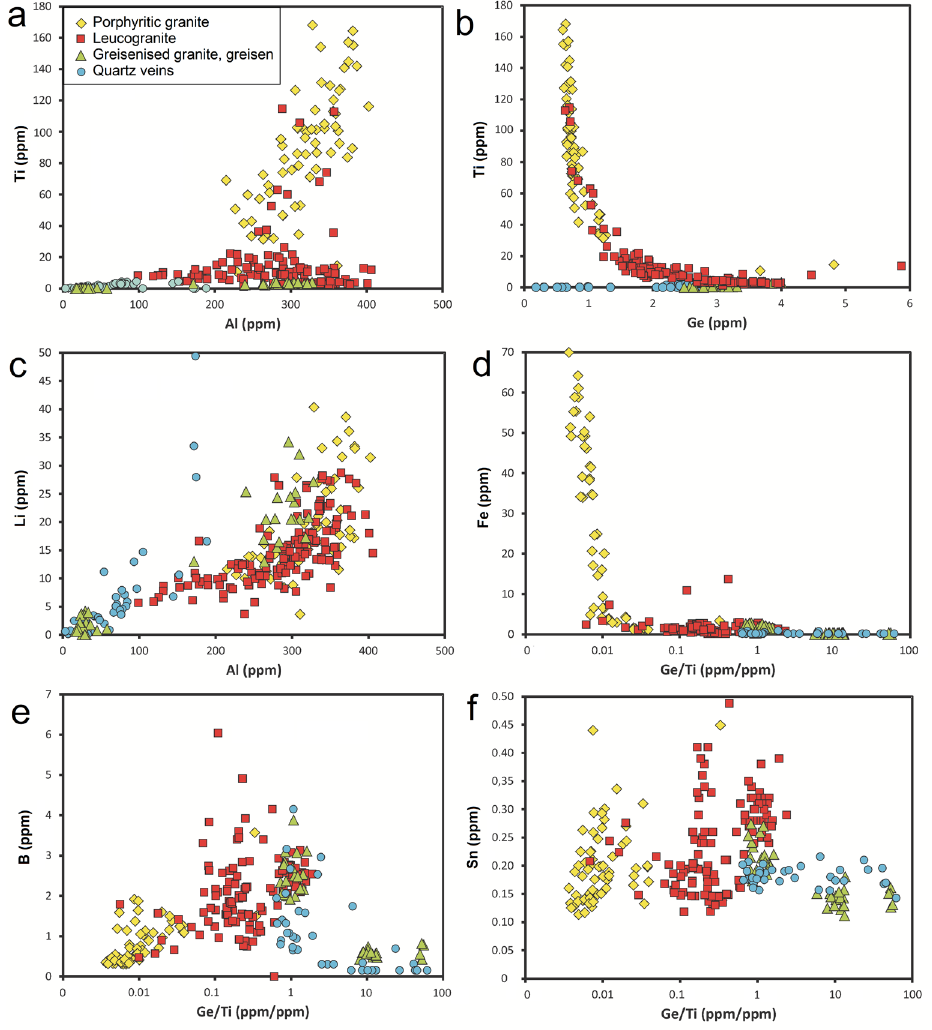
Figure 6. Contents of trace elements in quartz: ( a ) Al vs. Ti; ( b ) Ge vs. Ti; ( c ) Al vs. Li; ( d ) Ge/Ti vs. Fe; ( e ) Ge/Ti vs. B; ( f ) Ge/Ti vs. Sn.